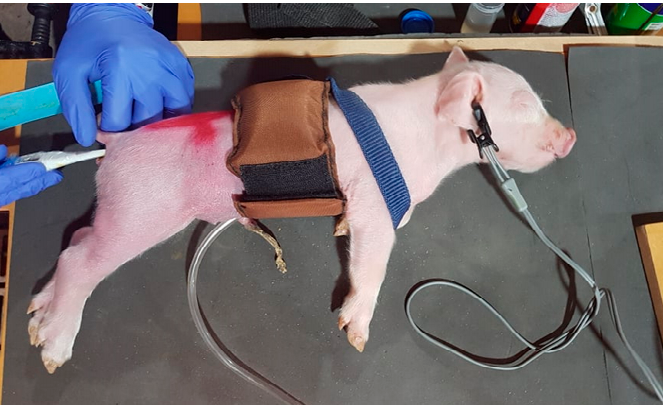
Figure 1. Rope squeeze applied to the thorax of a piglet, with vet wrap secured underneath the rope and pulse oximetry electrode attached to the ear.